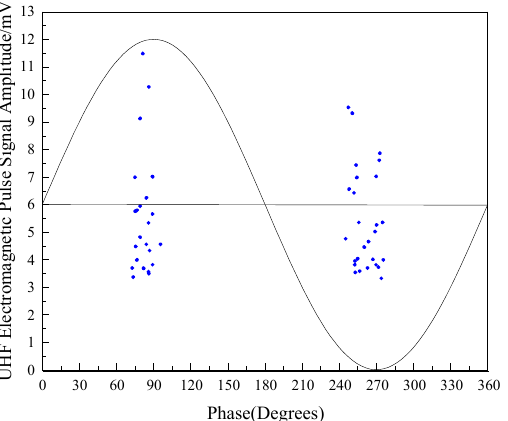
Figure 21. UHF electromagnetic pulse signal amplitude pattern of the filth defects inside GIS under 12.5 kV.